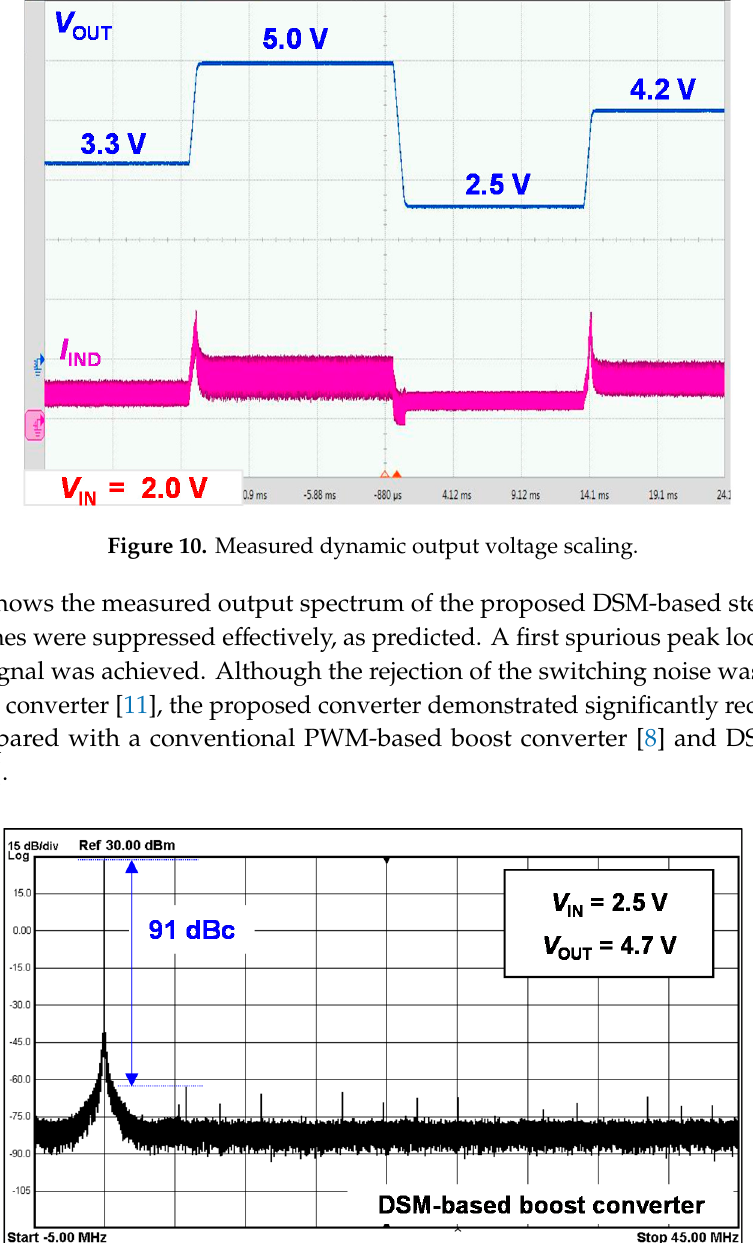
Figure 11. Measured output voltage spectrum.